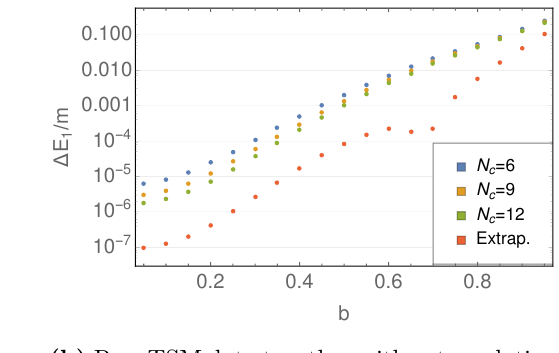
(a) Raw TSM data together with extrapolation (b) Raw TSM data together with extrapolation in N c for E gs at different b ’s. in N c for E exc at different b ’s. Figure 7. The behaviour of the N c -extrapolated TSM data as a function of b.